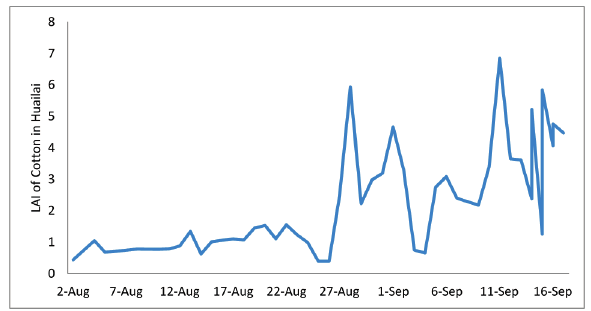
Figure 14. The change of corn LAI in Huailai.